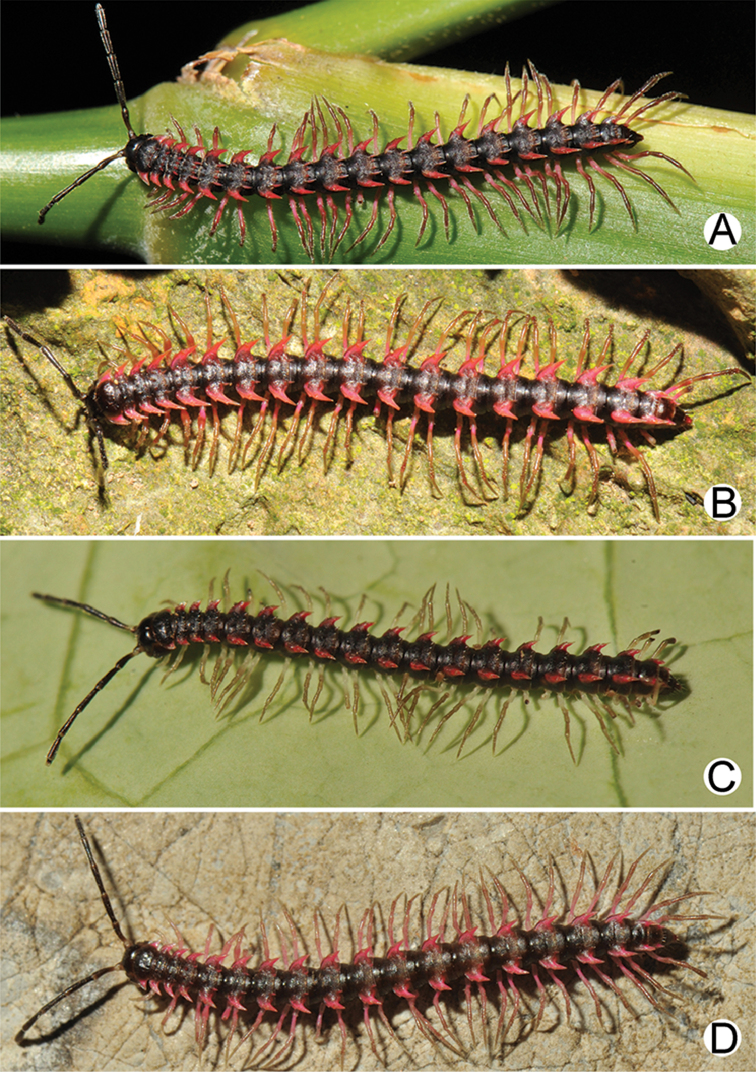
Photographs of live Desmoxytes
planata (Pocock, 1895) – males. A specimen from Xishuangbanna, Mengla (China) B specimen from Suan Sai Thong Restaurant, Phrae (Thailand) C specimen from Lampane Village, Nguwun Chuang River (Myanmar) D specimen from Wat Khao Tham Ma Rong, Prachuap Khiri Khan (Thailand).